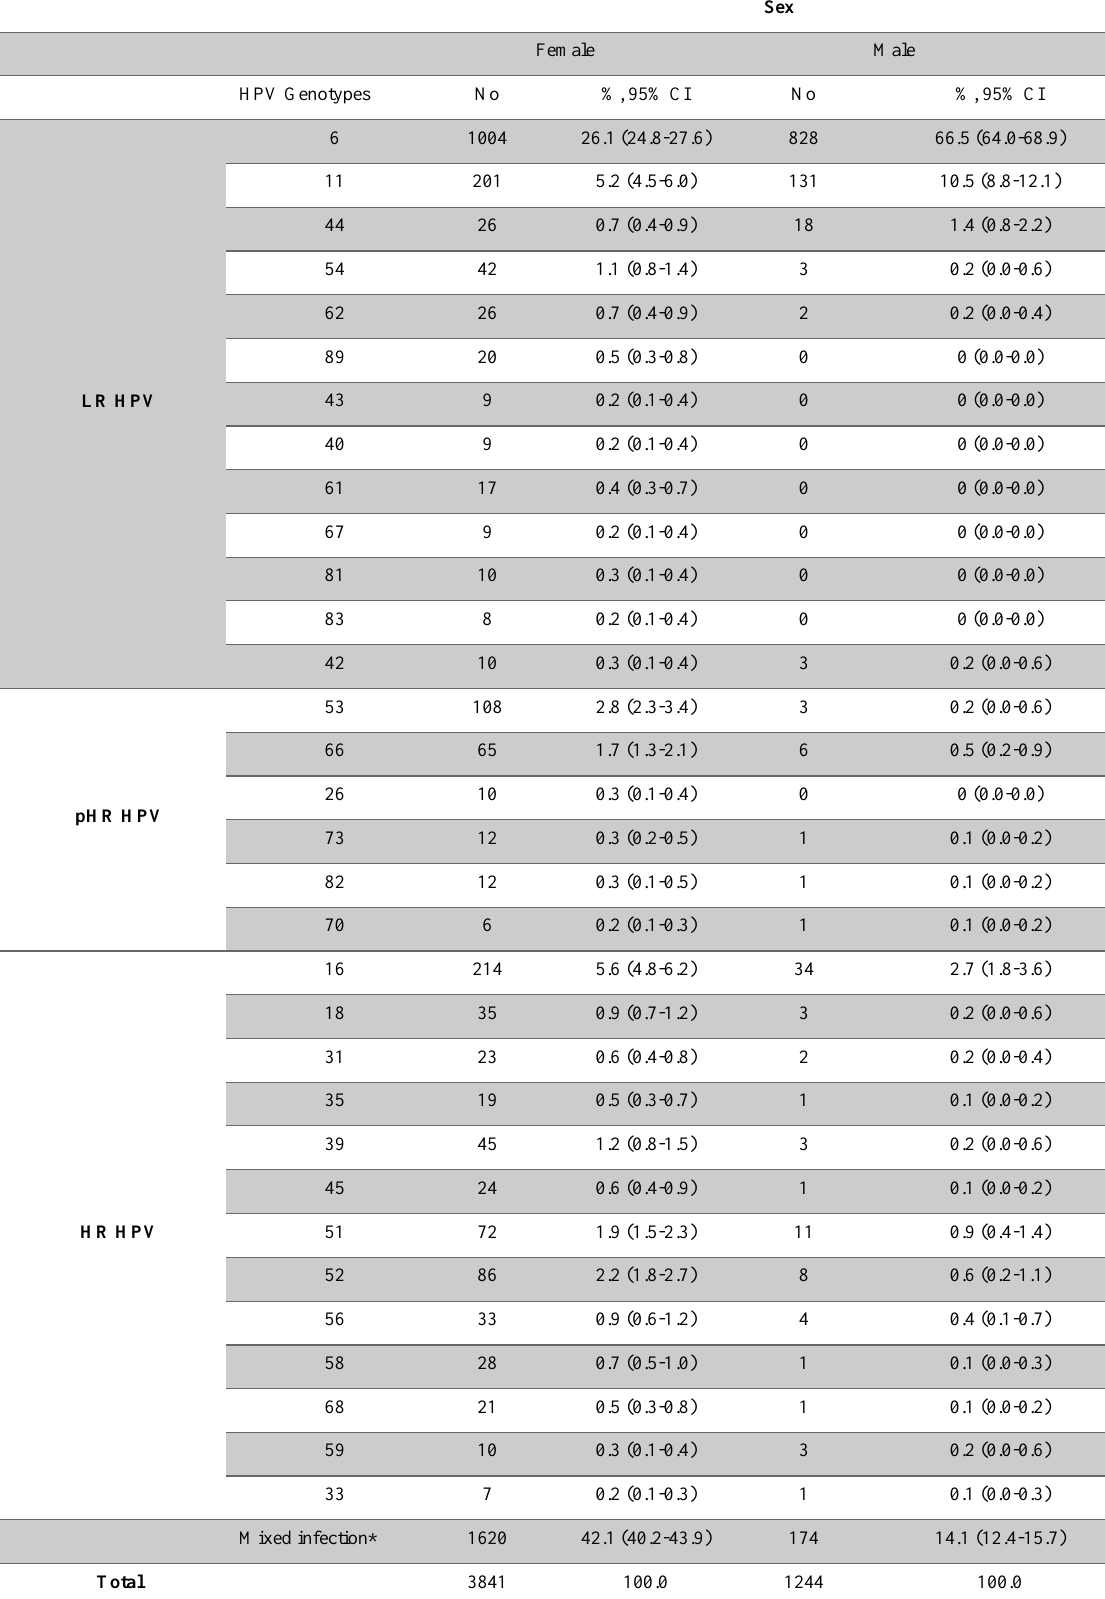
Figure 1. The percentage of HPV prevalence in the population (n=10266) of this study. HPV DNA was not detected in 44.0% and 6.5% of females and males, respectively; however, 37.4% of female subjects and 12.1% of male subjects were positive for HPV DNA. Table1. The prevalence of HPV genotypes as a single infection in Iranian female and male